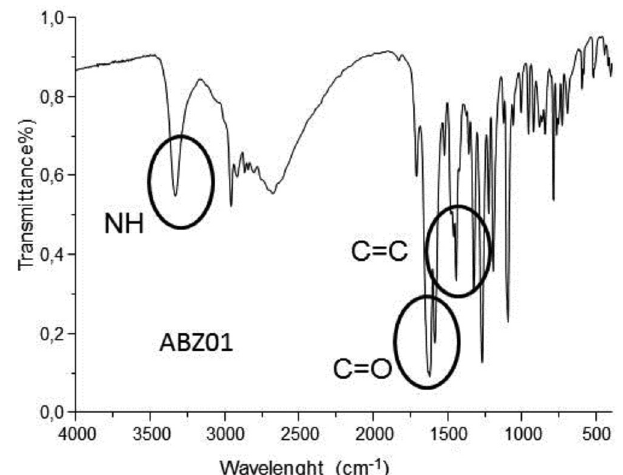
FIGURE 2 - Infrared spectrum of ABZ01 and its absorption